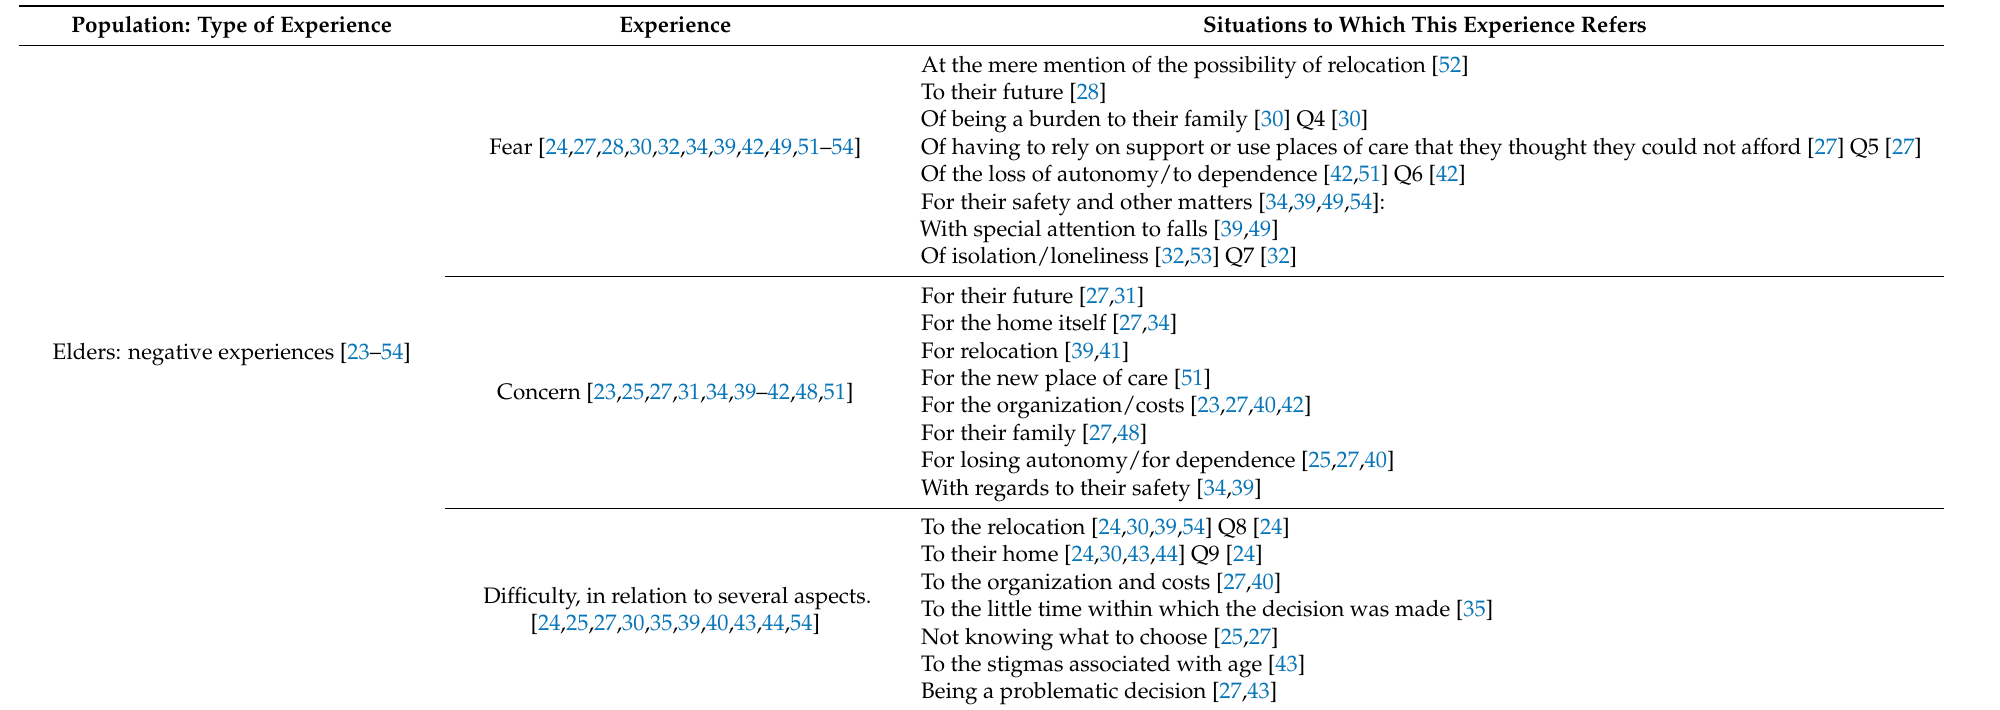
Table 2. Relevant negative experiences of the elderly a